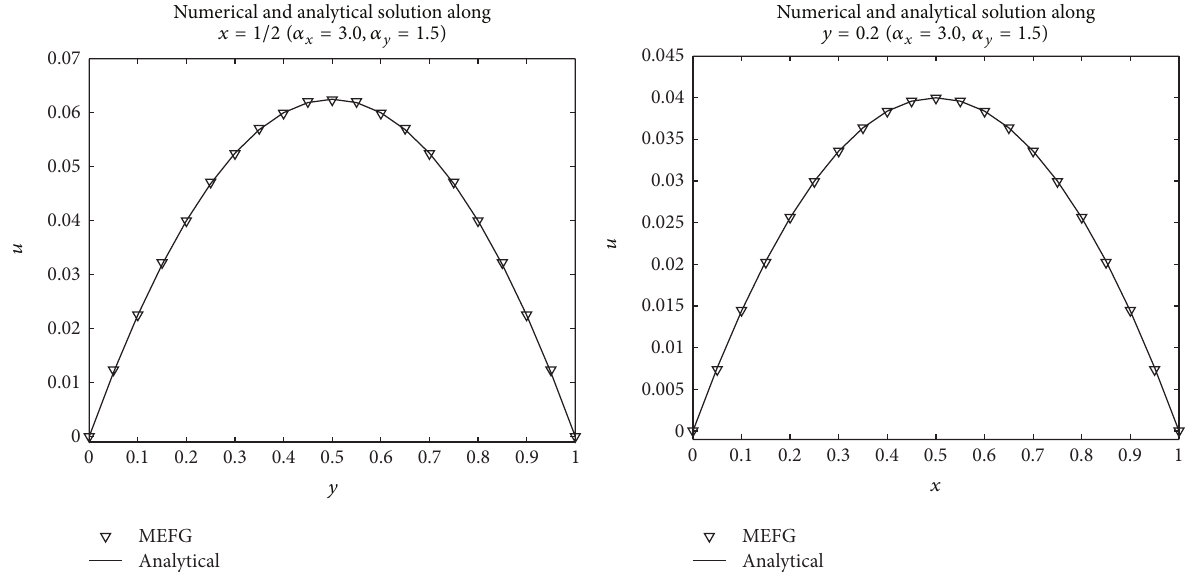
Figure 8: Comparison of analytical and MEFG